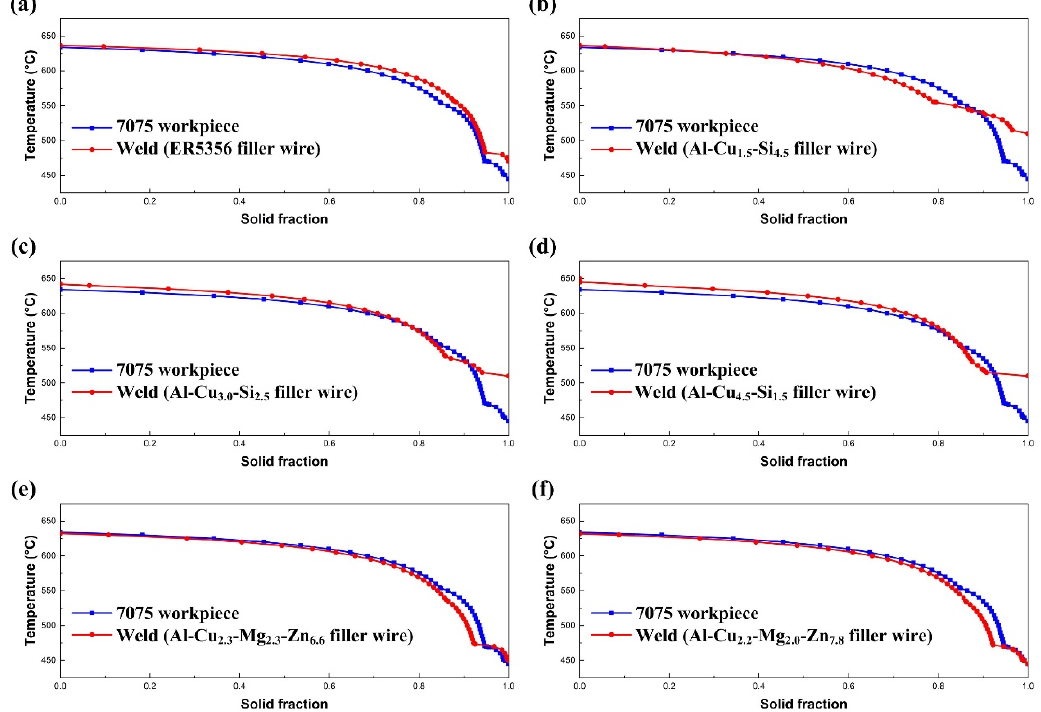
Figure 5. T-f S curves of different joints: ( a ) The AA7075/ER5356 joint; ( b ) AA7075/Al-Cu 1.5 -Si 4.5